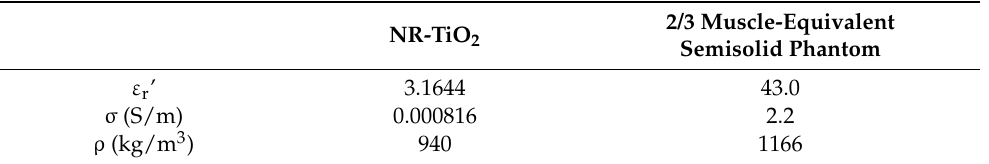
Table 1. Material properties of the antenna substrate (NR-TiO 2 ) and 2/3 muscle-equivalent phantom measured at 2.565